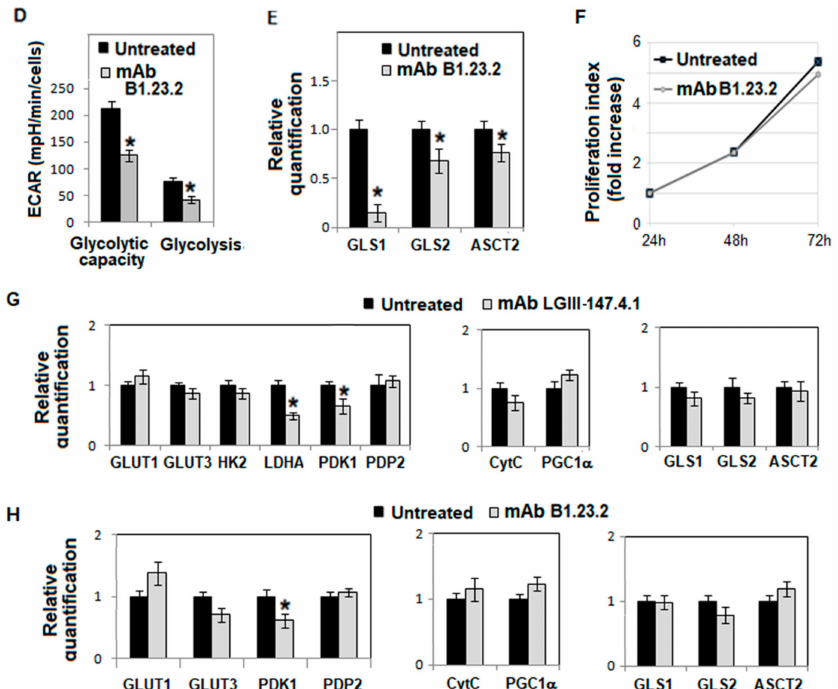
Figure 2. E ff ect of the HLA-B,C-specific mAb B1.23.2 on the metabolism of A375-M6 melanoma cells. Analysis of mRNA expression by quantitative real-time PCR of genes involved in glycolysis ( A ), oxidative phosphorylation ( B ) and glutamine metabolism ( E ) in A375-M6 melanoma cells treated with the HLA-B,C-specific mAb B1.23.2 (10 µ g / mL) for 24 h at 37 ◦ C. Western blot analysis of